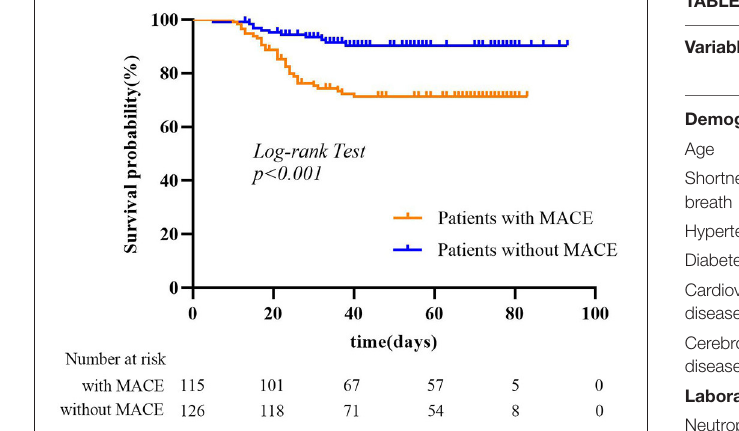
TABLE 3 | Risk factors associated with